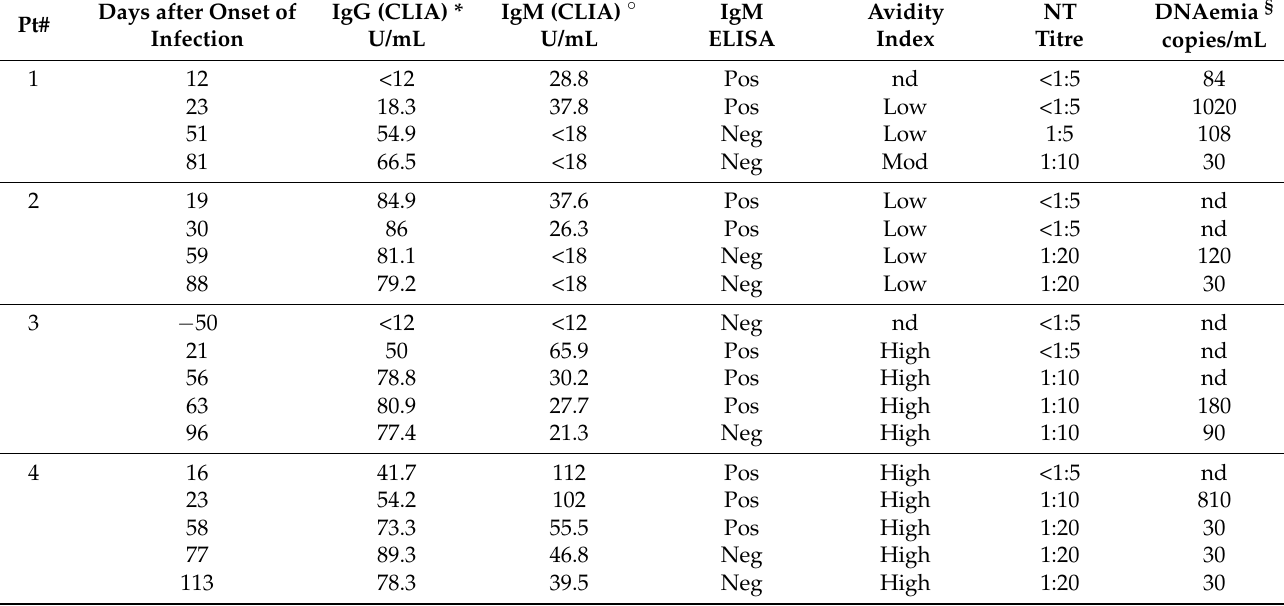
Table 1. Virological results in four representative women with early clearance of IgM antibody (Pt#1 and #2) and early high avidity index (AI) (Pt#3 and